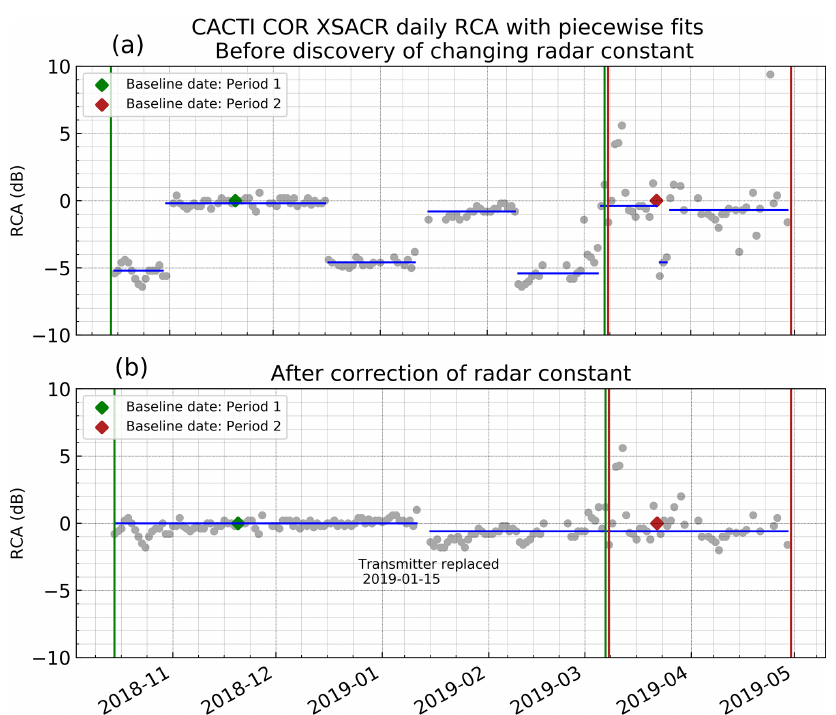
Figure 14. RCA time series for CACTI XSACR. Panel (a) corresponds to the RCA run without any corrections. The values jump between two piecewise constant values caused by changing radar constants. The vertical bar shows when the operational scan strategy was changed from 25 to 75m gates, and so a new composite clutter map was calculated. The RCA is shown in (b) after correcting for the piecewise jumps.